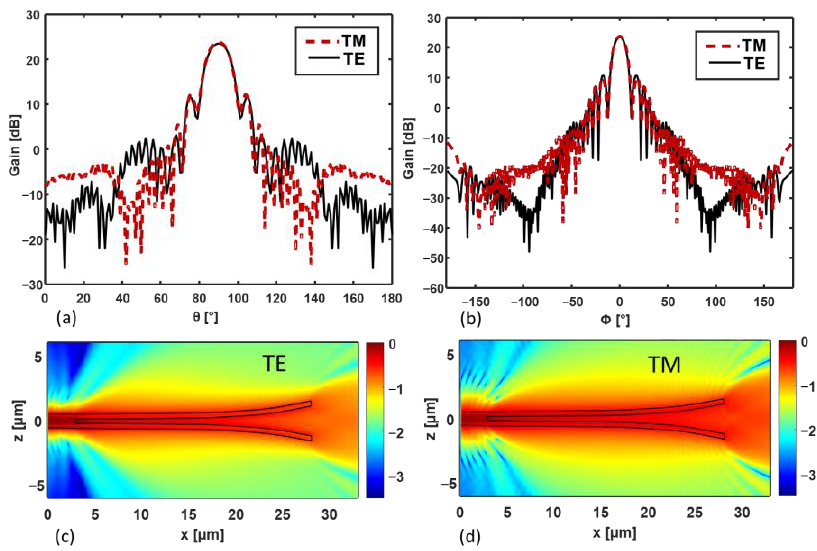
Figure 3. ( a , b ) Gain as a function of ( a ) the angle θ (with Φ = 0) and ( b ) the angle Φ (with θ = π /2), for the TE (solid curves) and TM (dashed curves) modes in the case of the Vivaldi antenna with strip width w = 900 nm, slot gap g = 300 nm, slot rail width s = 300 nm, and antenna length L a = 25 μm. ( c , d ) Electric field pattern calculated via 3D-FDTD in the xy plane for z = 0 μm (i.e. , in the middle of the antennas) for the TE ( c ) and TM ( d ) polarizations. The color bar represents the normalized amplitude of the electric field in logarithmic scale. The wavelength is λ = 1.55 µm.